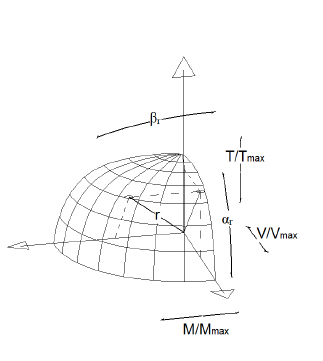
Figure 1: Relationship between torsion moment, bending moment and shear